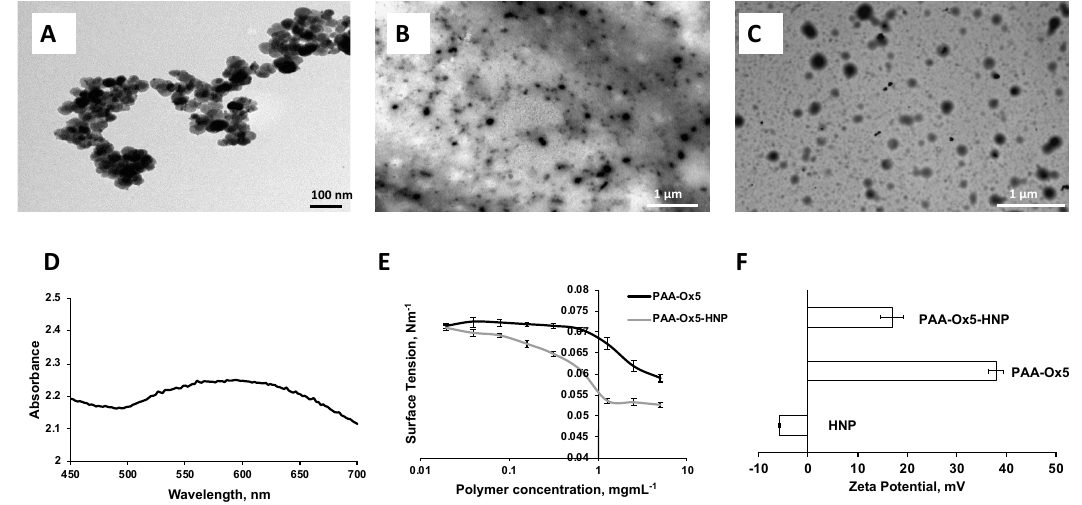
Figure 3. Physical characterisation. Transmission electron microscopy (TEM) images of ( A ) HNPs, ( B ) PAA-Ox5, and ( C ) PAA-Ox5-HNP. ( D ) Ultraviolet visible (UV-Vis) spectroscopy of HNPs, ( E ) surface tension measurements of amphiphiles, and ( F ) zeta potential measurement of samples in deionised water ( n = 3, ± standard